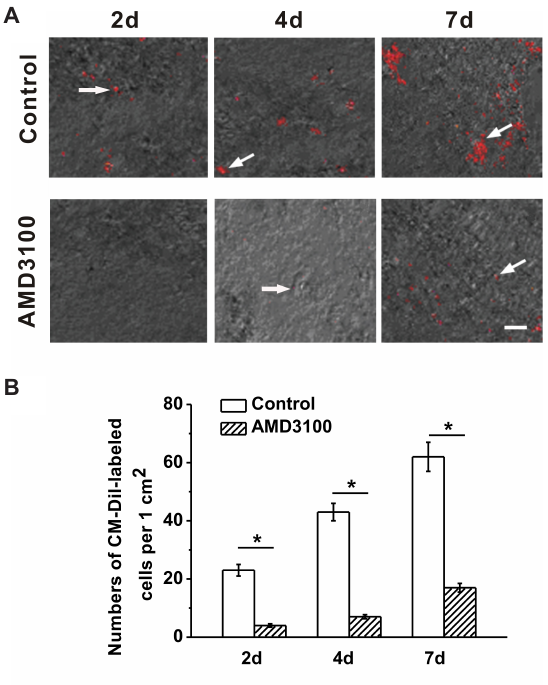
Figure 7. Inhibition of NSC migration under AMD3100 treatment. (A-C) The representative images of NSC migration from the neurospheres for 48 h in control, OGD-2 h and OGD- 5 h groups under 20 μg/ml AMD3100 treatment, respectively. Scale bar = 100 µm. The cells were stained blue for the nucleus. (D) Mean maximal distance migrated from the neurospheres for 10 h and 48 h. (E) Numbers of the migrated cells from the neurospheres. Data were presented as mean ± S.E.M.